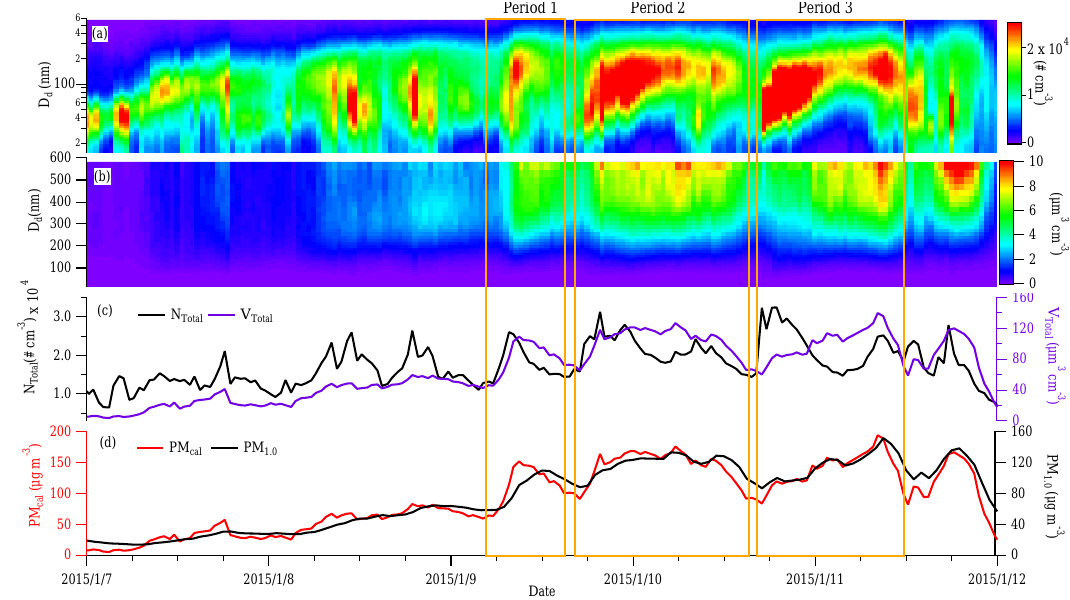
Figure 5. Temporal evolutions of particle number size distribution (a) , volume size distribution (b) , total number concentration and total volume concentration (c) , and PM 1 . 0 concentration and calculated PM (less than 600nm in mobility diameter) concentration during the representative PM episode from 7 to 12